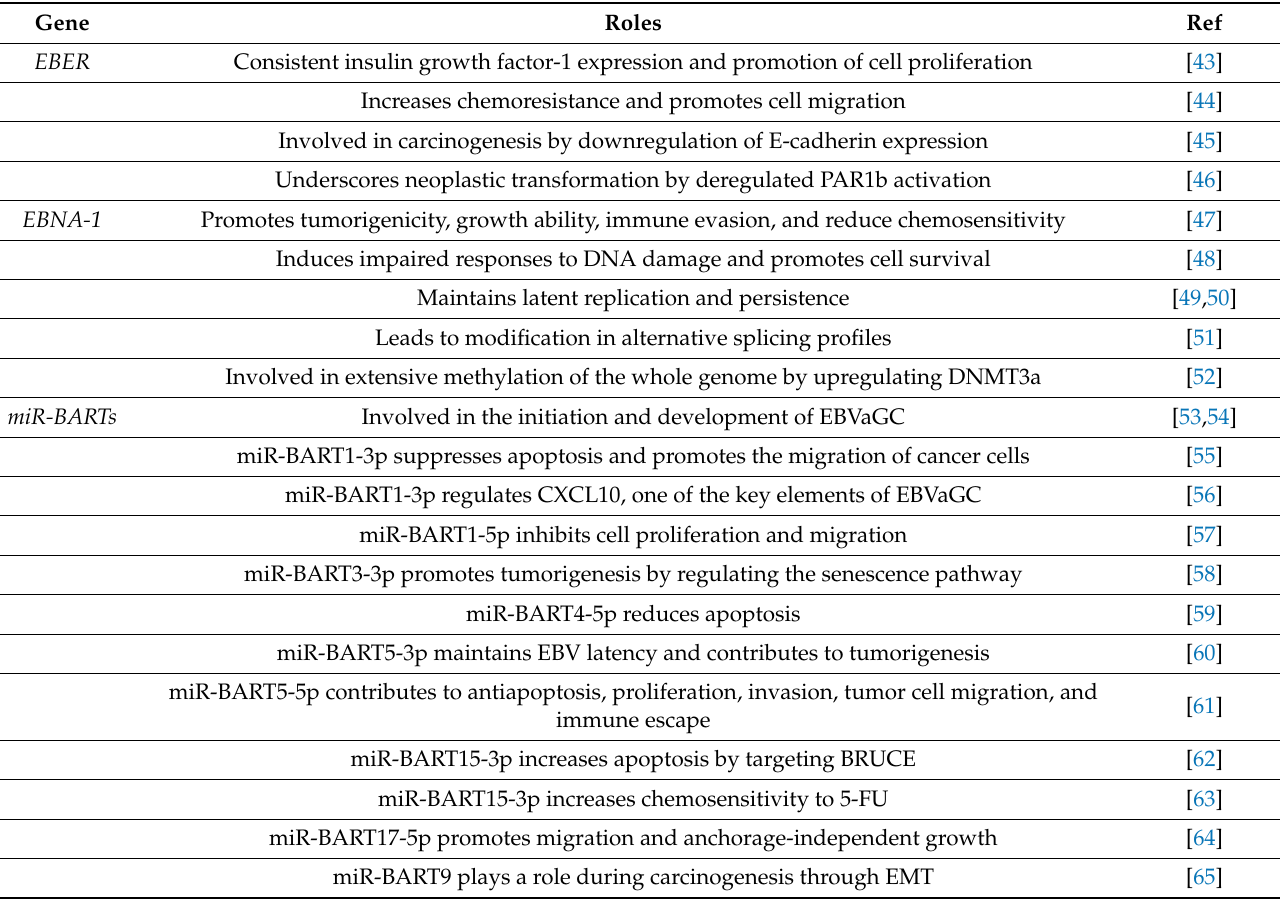
Table 1. EBV genes and their functional roles in EBV-associated gastric